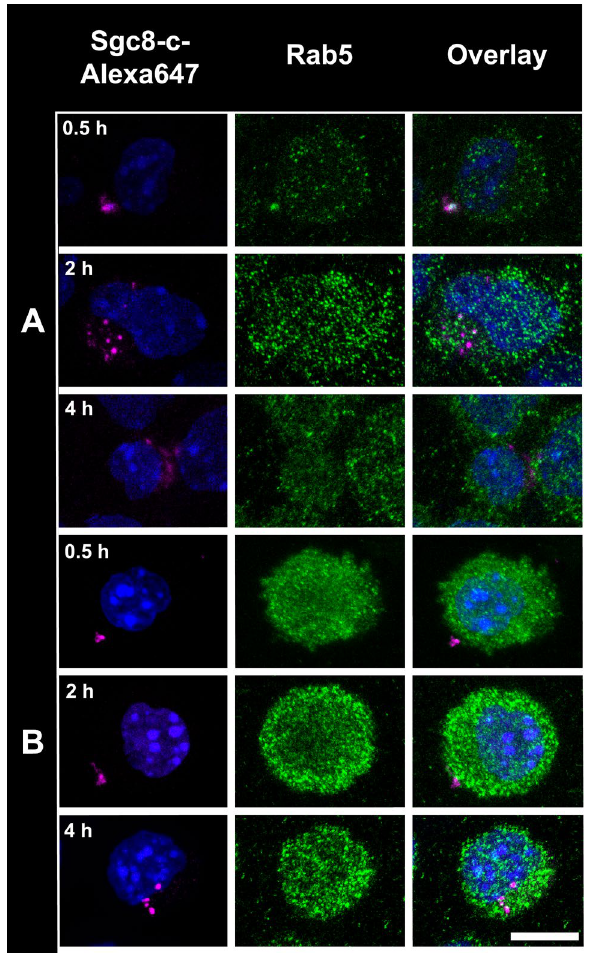
Figure 5. Sgc8-c-Alexa647 co-localize within endosomes. Confocal microscopy of ( A ) B16F10 and ( B ) B16F1 tumor cells incubated for 0.5, 2 and 4 h with the probe. Magenta: Sgc8-c-Alexa647, Blue: Hoechst and Green: Rab5 . Scale bar: 10